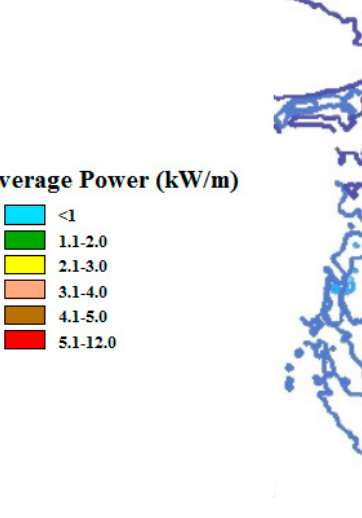
Figure 4. Measuring buoys installed along the Sicilian coasts.